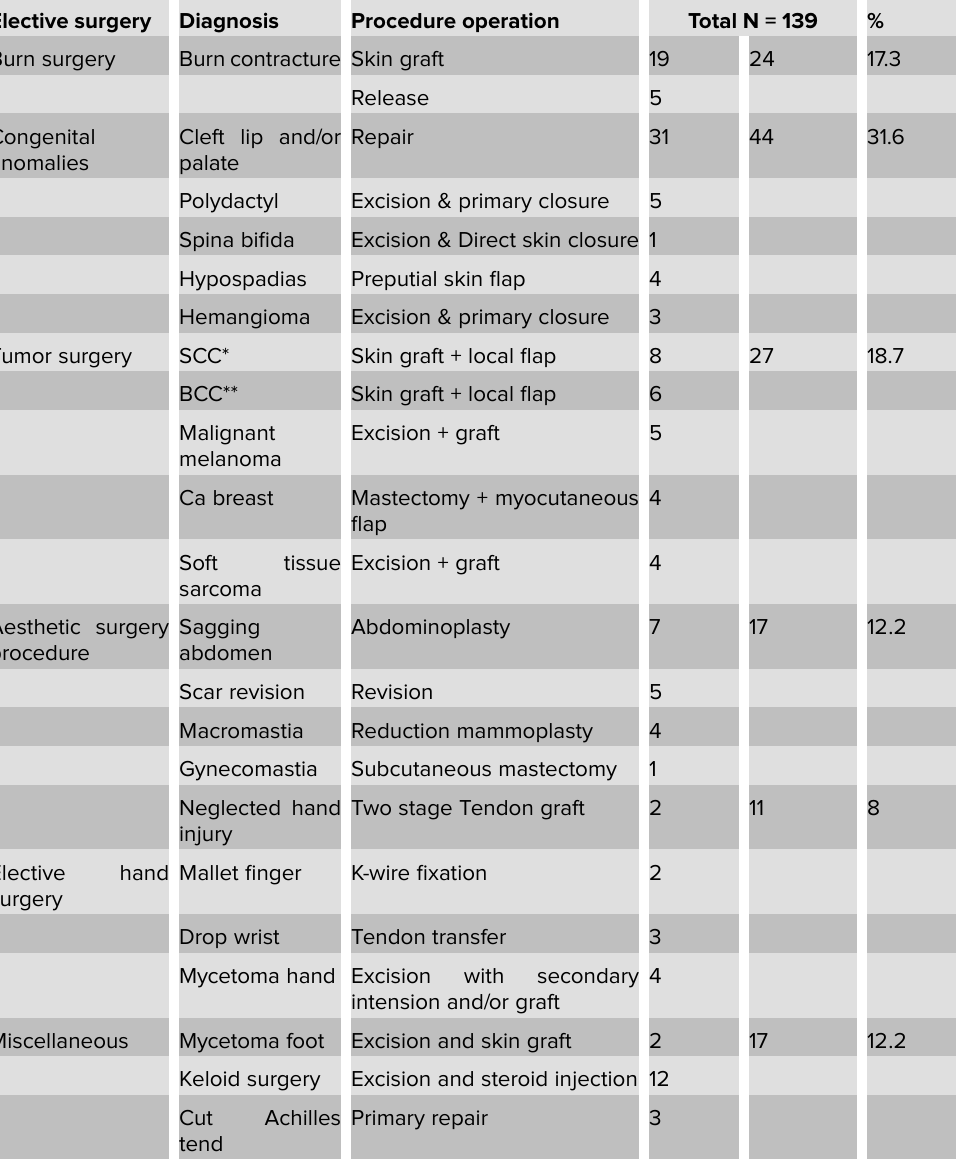
Table 2: Types of elective reconstructive